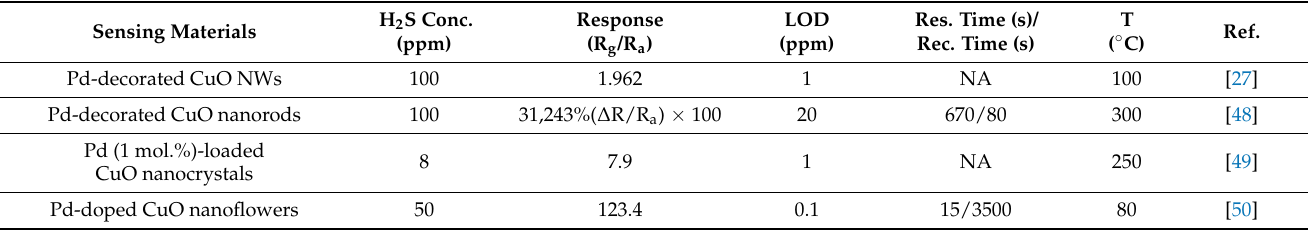
Table 3. H 2 S gas-sensing properties of noble metal-decorated/doped CuO-based gas sensors. H 2 S Conc. Sensing Materials